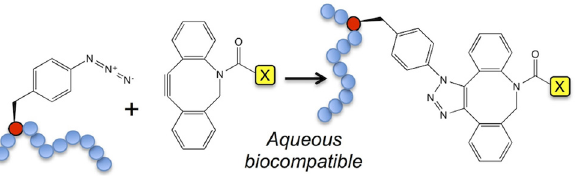
Fig 3. SPAAC between genetically encoded azide (red sphere) within a protein (blue spheres) and an activate alkyne (dibenzylcyclooctyne;DBCO). A triazole link is formed between the azide and alkyne